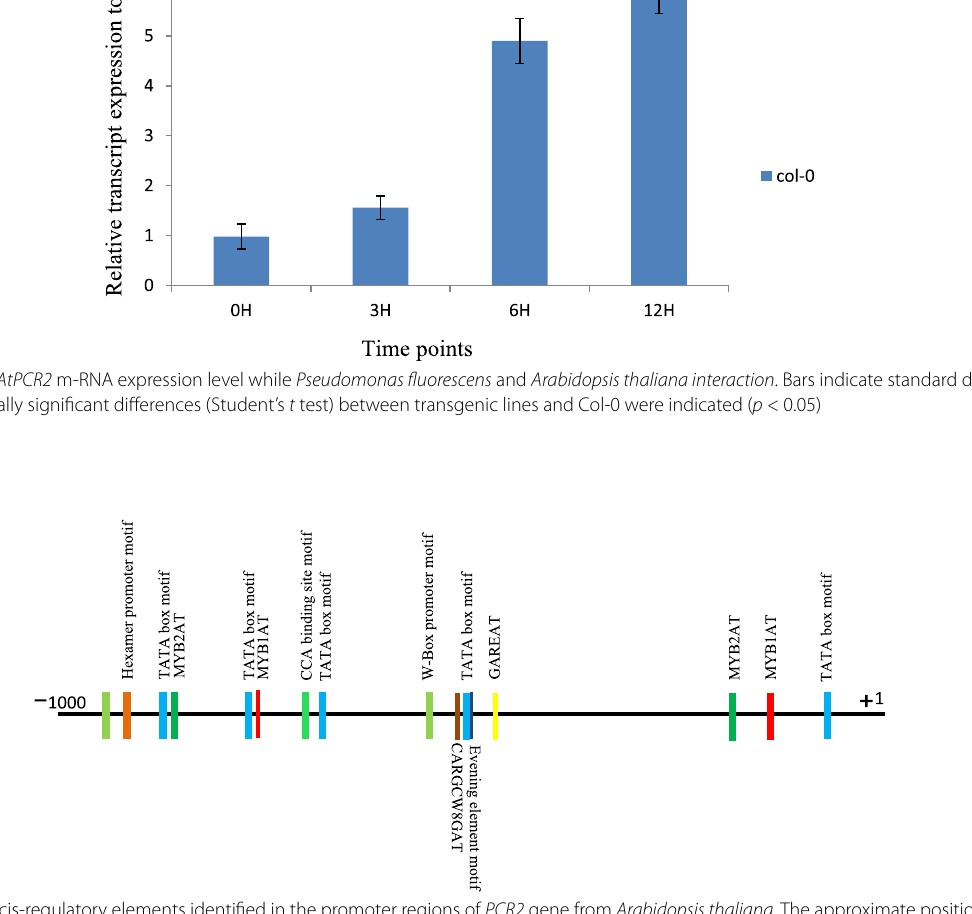
Fig. 2 Putative cis-regulatory elements identified in the promoter regions of PCR2 gene from Arabidopsis thaliana . The approximate positions of putative cis-regulatory elements were predicted in the 1 kb upstream region of the PCR2 gene by PlantCARE